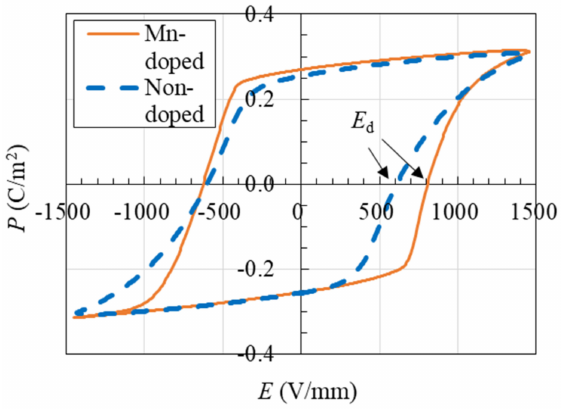
Figure 5. Polarization ( P )–electric field ( E ) hysteresis loops of Mn-doped and non-doped PIN-PMN- PT